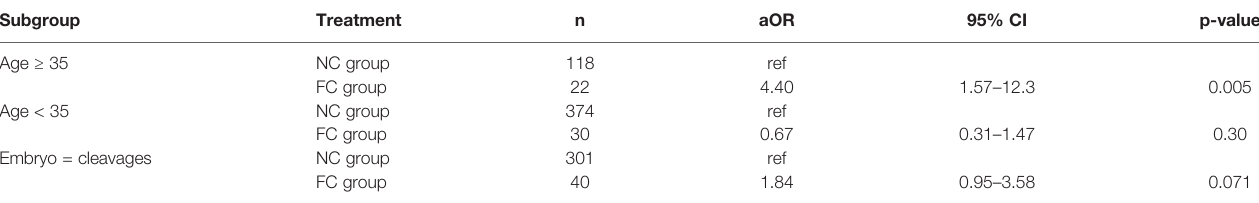
TABLE 5 | Multivariate analysis showing the association between triggering GnRHa-induced FC with clinical pregnancy in subgroup of age ≥ 35, age <35, and embryo transferred = cleavages. Subgroup